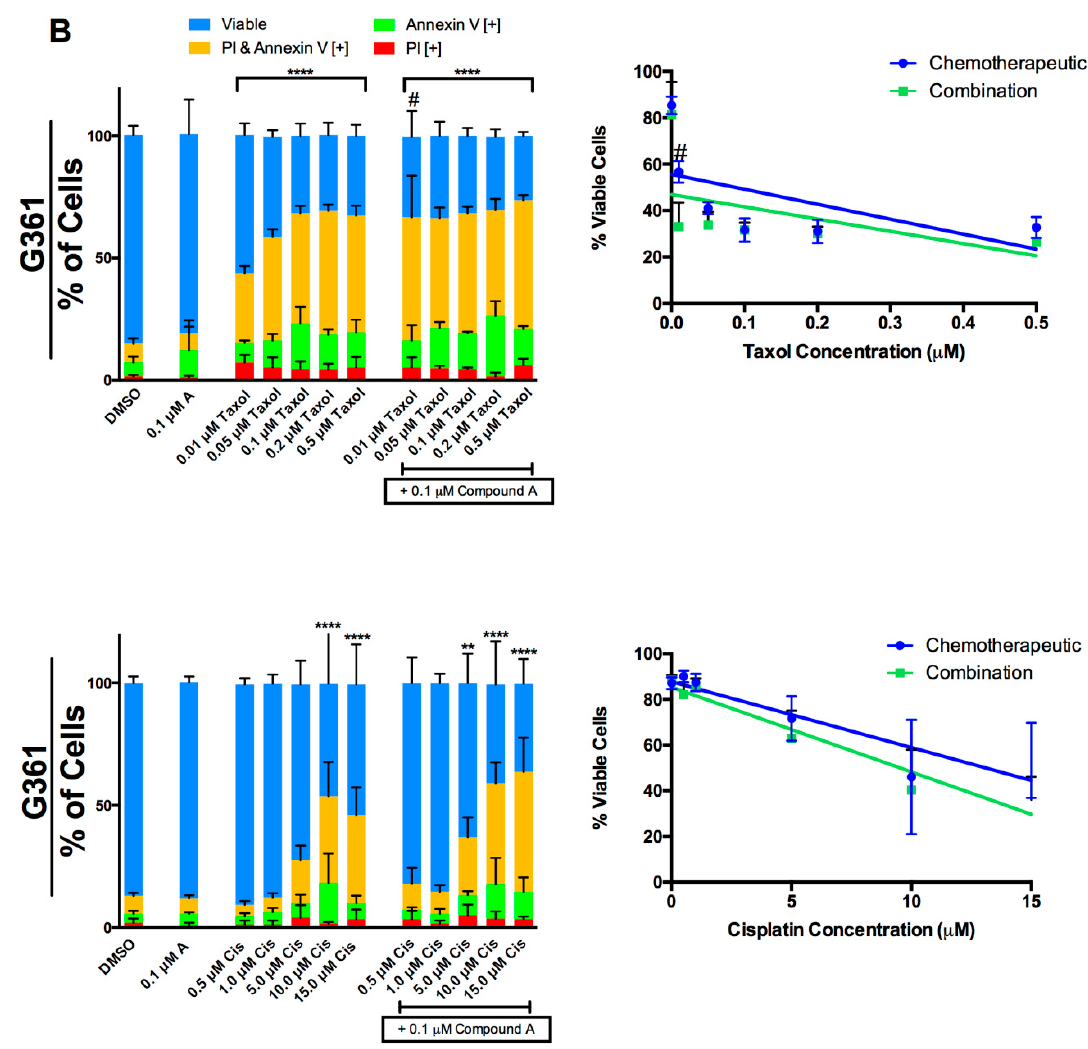
Figure 5. The interaction of Compound A with taxol and cisplatin in two melanoma cell lines. ( A ) A375 and ( B ) G361 melanoma cells were treated with a range of taxol (top panel) and cisplatin concentrations (bottom panel) alone and in combination with a sub lethal dose of Compound A (0.1 µ M). Following 48 h of treatment the cells were stained with Annexin V and PI to distinguish early apoptosis and late stage apoptosis, respectively. Image based cytometry was utilized to assess apoptosis. The y -axis represents the percent of cells positive for Annexin V (green), PI (red), Annexin V and PI (yellow), or negative for both Annexin V and PI (blue). All graphical values are expressed as a mean ± SD from three independent experiments. A line graph was constructed using viability values for individual chemotherapeutics in the absence and presence of Compound A (combination). ** p < 0.01 vs. DMSO control (comparison of viable cells only); **** p < 0.0001 vs. DMSO control (comparison of viable cells only); # p < 0.0001 vs. 0.01 µ M taxol alone (comparison of viable cells only). Cis = Cisplatin .